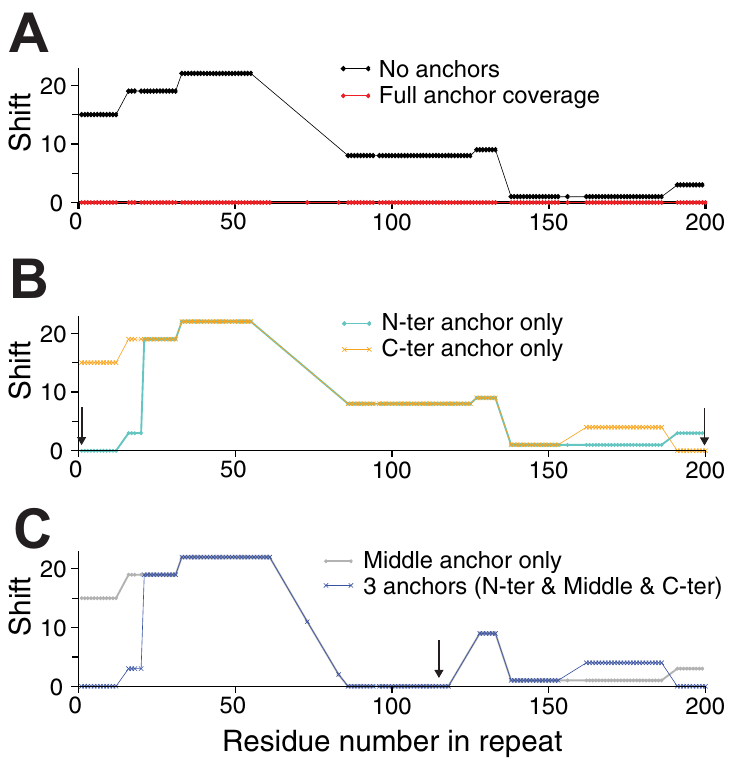
Fig 5. Extensive anchor coverage guarantees accurate alignments when using computationally-efficient alignment methods for very challenging chases, shown for the internal repeats of LeuT aligned using AlignMe Fast mode. The number of columns by which a residue is shifted from position in the reference alignment is shown for all aligned residues in the repeats. The reference alignment, obtained from a structure-based symmetry detection method, is shown in S2 Fig. Alignments were obtained (A) without any anchors ( black circles ), or with anchors covering all secondary structure elements ( red circles ), (B) with a single anchor at the N- or C-terminal end of the alignment ( cyan circles , orange crosses , respectively ), marked with arrows, (C) with a single anchor in the center of the alignment ( gray circles ), marked by an arrow, or with three anchors at the beginning, middle and end ( blue crosses ). Note that residues aligned to gaps are not scored using this measure, and the residue numbering corresponds to that in the second